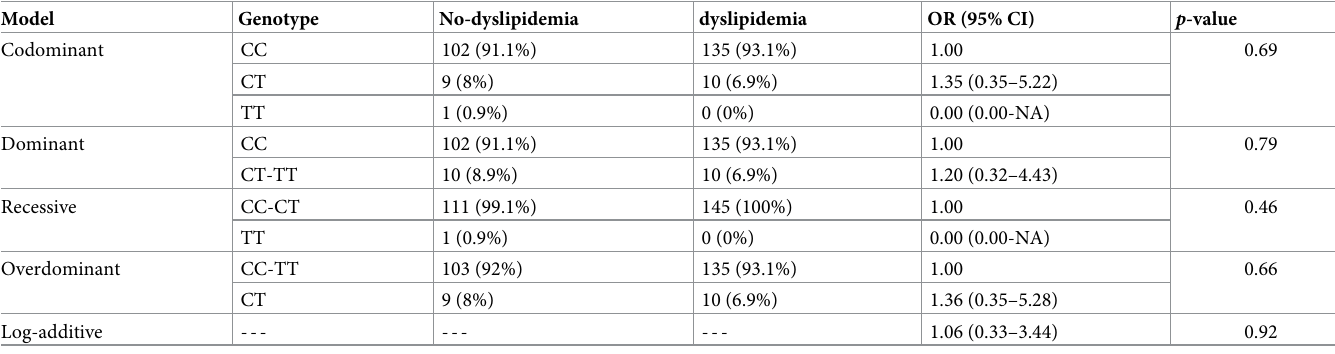
Table 7. Polymorphism rs1527483 association with response dyslipidemia based on "SNPStats" analysis tool.